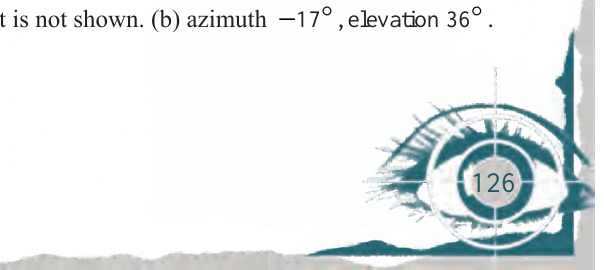
Figure 17 A pencil with divergency 4/ LJIM ++−= D at T. The two principal meridional planes are not orthogonal. The fo- cal plane at infinity in Figure 16 is now at a reduced distance of about 32 m. It is not shown. (b) azimuth °− 20 17 °− 20 , elevation 36 °− 20